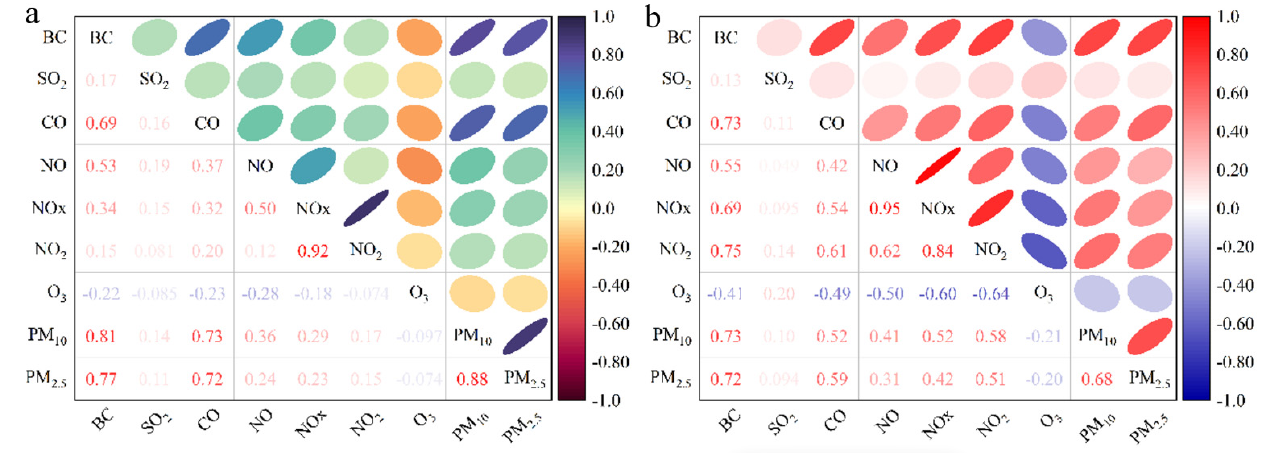
Figure 7. Correlation analysis of SO 2 , CO, NO, NO X , NO 2 , O 3 , PM 10 , PM 2.5 , and BC for the heating and non-heating seasons (( a ): heating season; ( b ): non-heating season). CO was primarily derived from the incomplete combustion of coal and gasoline